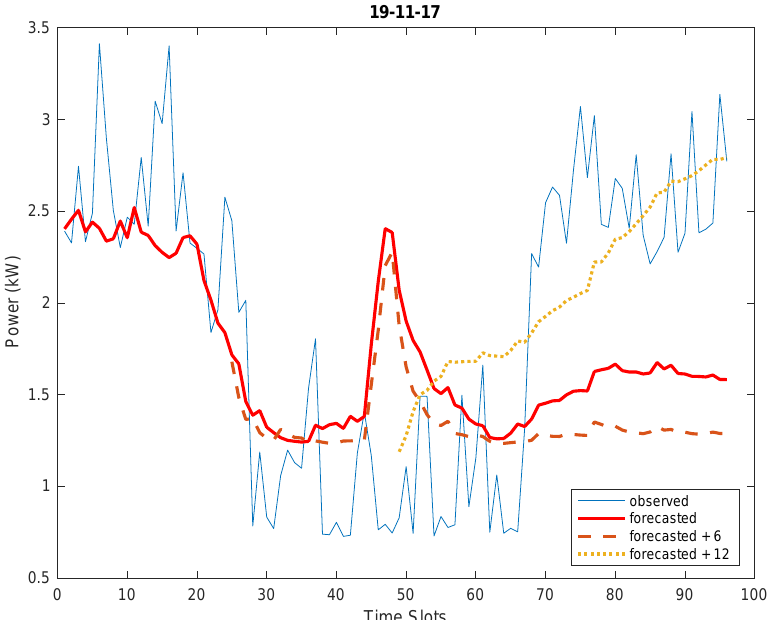
Figure 15. Pilot system: School (Palo del Colle), Day: 19 November 17. Daily forecasts vs. observed power